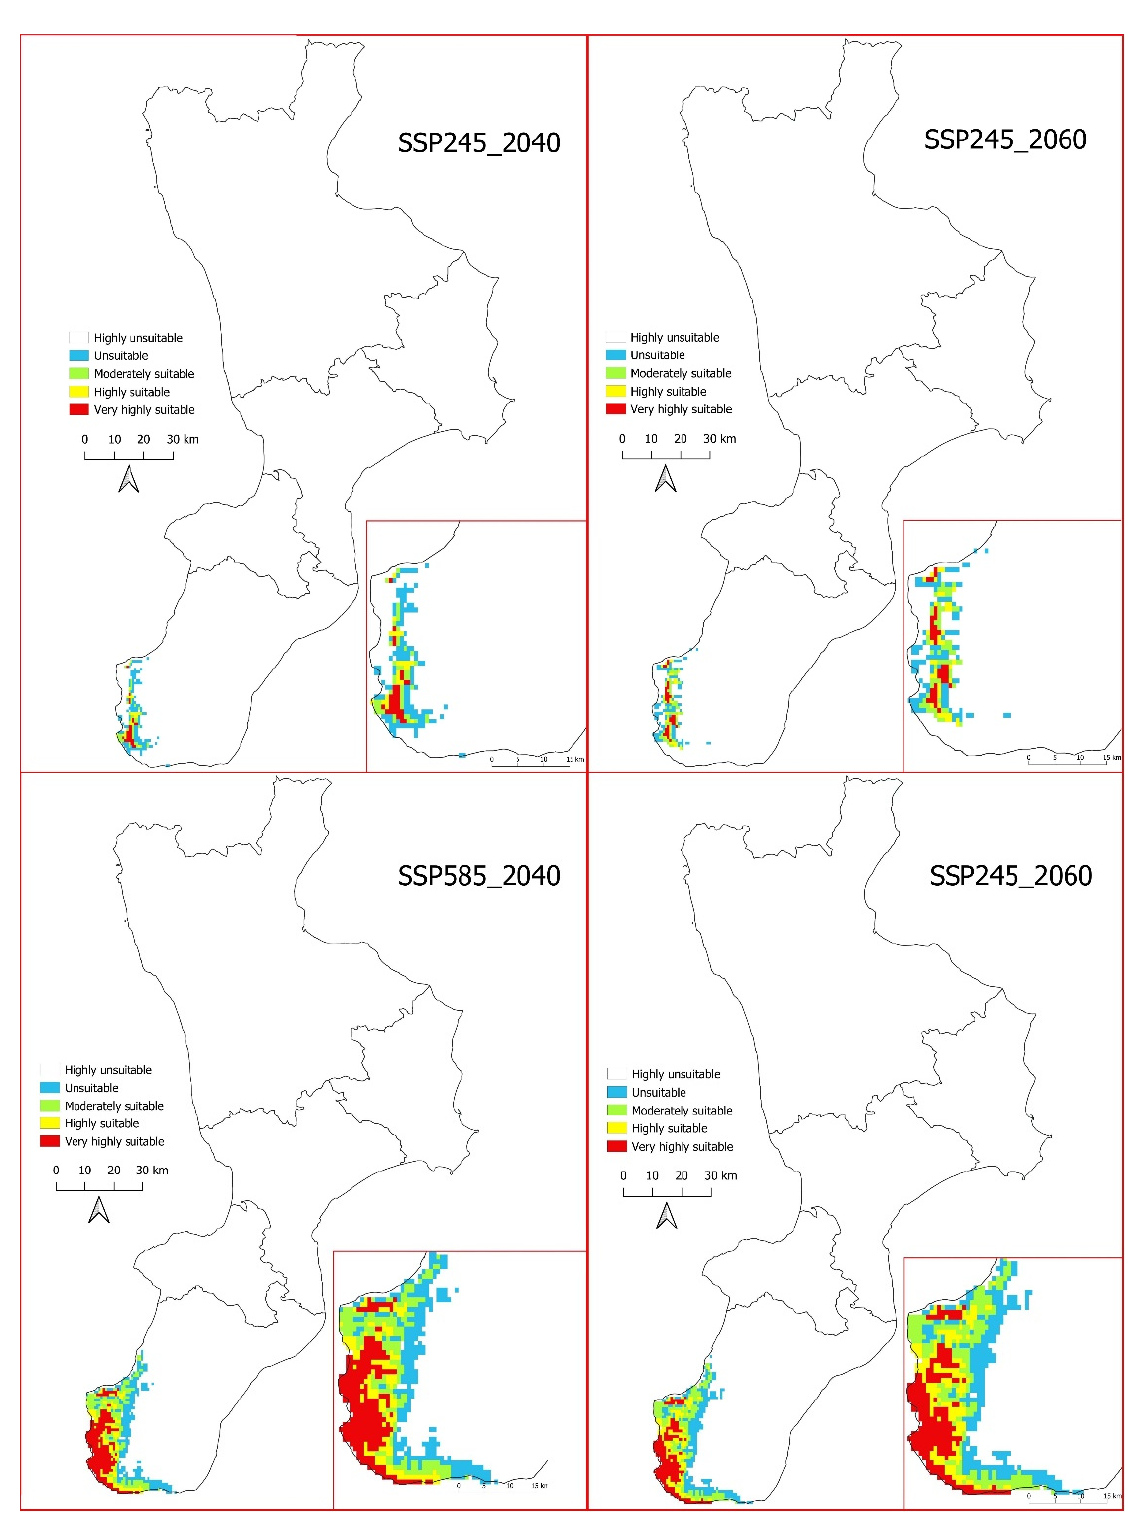
Figure 7. Prediction of the future potential distribution of Salvia ceratophylloides Ard. in two different scenarios SSP245 and SSP585 in two periods 2021–2040, 2041–2060. In white, highly unsuitable ( ≤ 0.20); in blue, unsuitable (0.21–0.40); in green, moderately suitable (0.41–0.60); in yellow, highly suitable (0.61–0.80); and in red, very highly suitable ( ≥ 0.80).